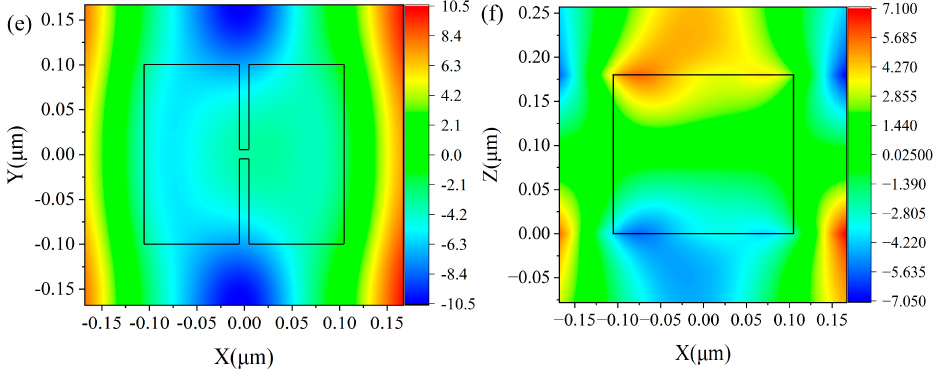
Figure 5. E z component of the near − fi eld distributions of an incident angle near the BIC modes ( a ) ( a ) at the x-y cross section at z = 0 µ m and ( b ) at the x-z cross section, at y = 0 µ m, θ = 0.01 ◦ and at the x − y cross section at z = 0 µm and ( b ) at the x − z cross section, at y = 0 µm, θ = 0.01° and λ = λ = 0.5647652 µ m; ( c ) at the x-y cross section at z = 0 µ m and ( d ) at the x-z cross section, at y = 0 µ m, 0.5647652 µm; ( c ) at the x − y cross section at z = 0 µm and ( d ) at the x − z cross section, at y = 0 µm, at at θ = 0.01 ◦ , and λ = 0.534339 µ m; ( e ) at x-y cross section at z = 0 µ m and ( f ) at x-z cross section, at θ = 0.01°, and λ = 0.534339 µm; ( e ) at x − y cross section at z = 0 µm and ( f ) at x − z cross section, at y = 0 µm, θ = 18.91°, and λ = 0.6891059 µm, of the H − shaped nanohole metasurface. a = 0.336 µm, L 1 = y = 0 µ m, θ = 18.91 ◦ , and λ = 0.6891059 µ m, of the H-shaped nanohole metasurface. a = 0.336 µ m, L 2 = 0.2 µm, W 1 = W 2 = 0.1 µm. L 1 = L 2 = 0.2 µ m, W 1 = W 2 = 0.1 µ m.